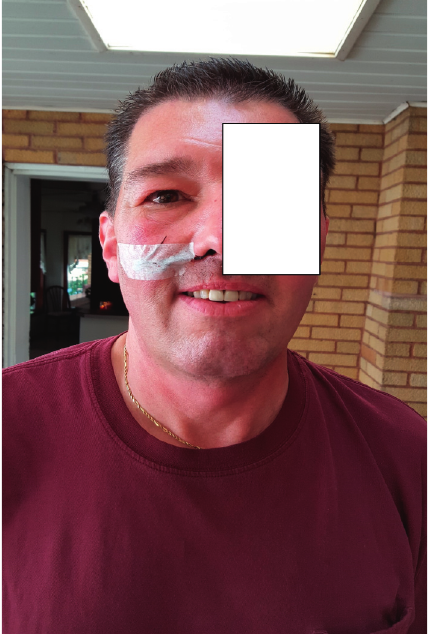
Figure 1: Reduction of swelling and erythema was noted around the right paranasal sinuses and right eye after nasal washout.